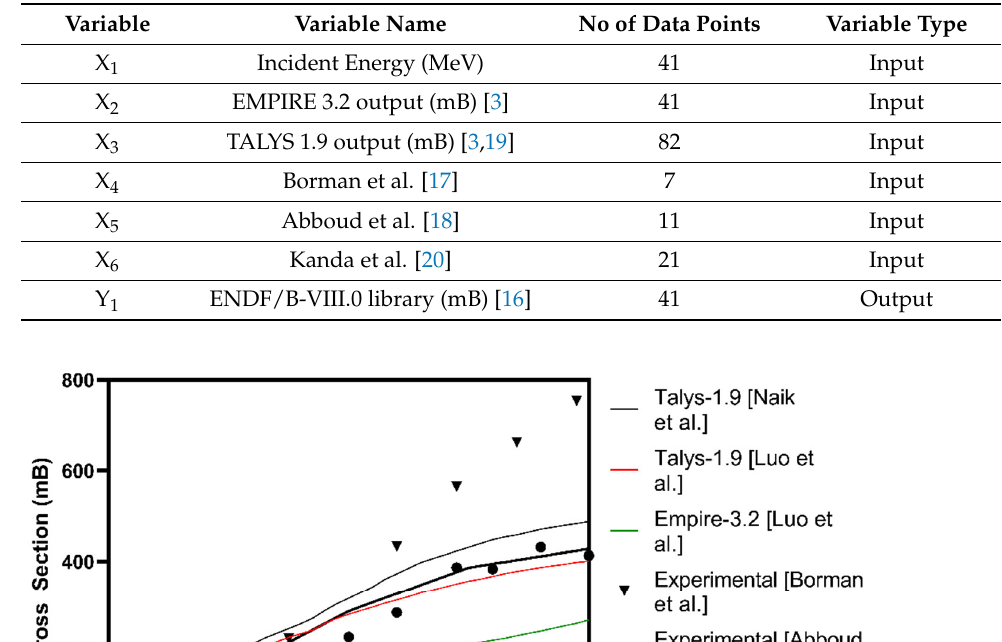
Table 1. Variables used as the input and output for prediction of nuclear cross-section data of 92 Mo ( n ,2 N ) 91 Mo. The experimental dataset (EXP) includes experimental data from Borman et al. [17], Abboud et al. [18] and Kanda et al. [20] while the crude estimation property (CEP) includes EMPIRE 3.2 and TALYS 1.9 data from Luo and Jiang 3 and TALYS1.9 data from Naik et al. [19].